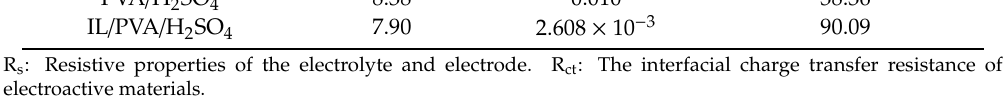
Figure 5. Ragone plot of the SSC based on two GPEs ( A ) and the capacitance retention rate of SSC-IL/PVA/H 2 SO 4 ( B ) at 5 mA/cm 2.